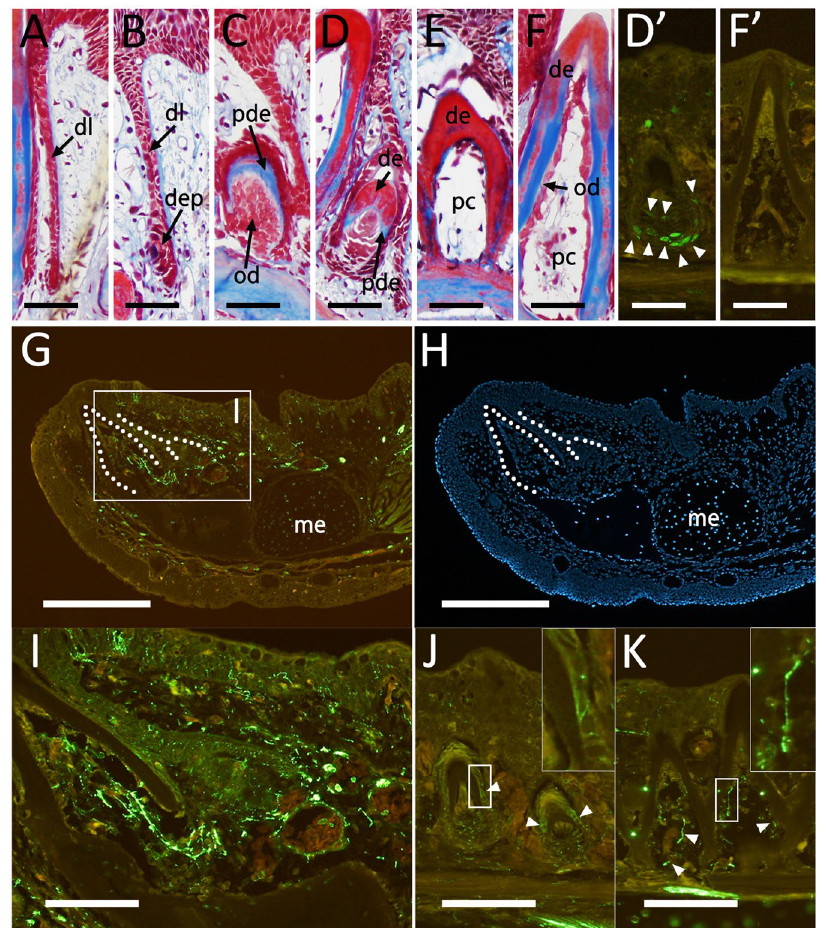
Figure 2. ( A–F ) Histological observations of the axolotl tooth. Masson’s trichrome staining visualizes collagen fibers in blue, cytoplasm in red and nuclei in dark purple. dl = dental lamina. dep = dental epithelium. od = odontoblasts. pde = predentine. de = dentine. pc = pulp cavity. ( D’ F’ ) Cell proliferation was visualized using BrdU staining on the adjacent sections of D and F, respectively. Arrowheads in D’ indicate the BrdU-positive cells. ( G–K ) Nerve presence was visualized using anti-acetylated tubulin antibody. H shows Hoechst33342 signals on the same section depicted in G. Arrowheads in J and K indicate the Acetylated tubulin-positive cells in the developing tooth buds. I is the higher magnification view of the boxed region in G. The insert in J and K shows higher magnification views of the respective boxed regions. The dotted lines in G and H indicate a functional tooth and a tooth bud. dl = dental lamina. dep = dental papilla. pde = predentine. de = dentine. od = odontoblast. pc = pulp cavity. me = Meckel’s cartilage. Scale bars in A–F, and I–K are 200 μ m. Scale bar in G and H is 500 μ m. Data are representative of n =